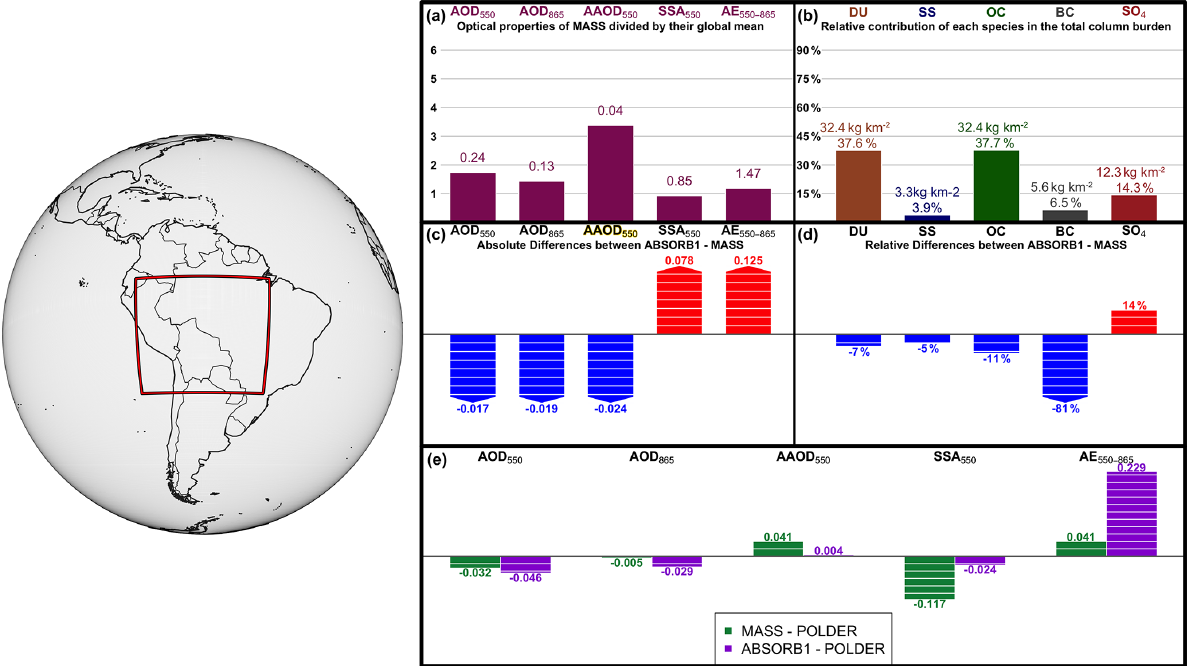
Figure 14. Similar to Fig. 13 but for South America. The depicted experiments are MASS and ABSORB1; hence, the changes in panels (c) and (d) are based on the addition of AAOD 550 to the